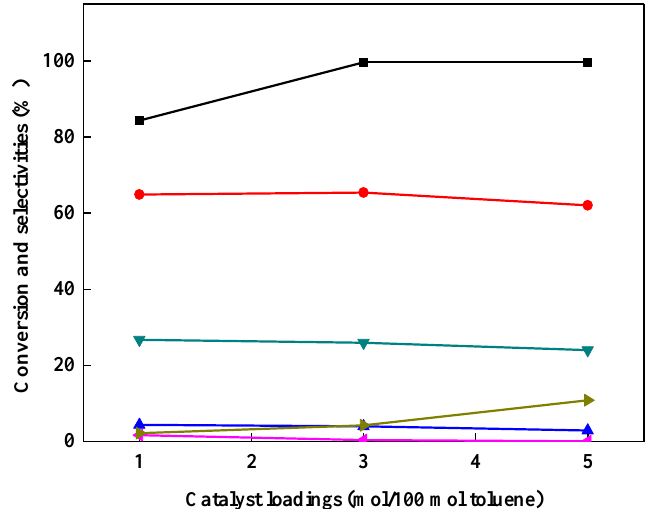
Figure 3. Chlorination of toluene with gaseous Cl 2 over the [BMIM]Cl-2ZnCl 2 ionic liquid catalyst with different loadings. ■ , conversion of toluene; ●, selectivity of o -chlorotoluene; ▲ , selectivity of m -chlorotoluene; ▼ , selectivity of p -chlorotoluene; ◄ , selectivity of benzyl chloride; ► , selectivity of dichlorotoluenes. Reaction conditions: toluene, 0.5 mol; chlorine, 25 mL min −1 ; reaction temperature, 80 °C; reaction time, 8 h.